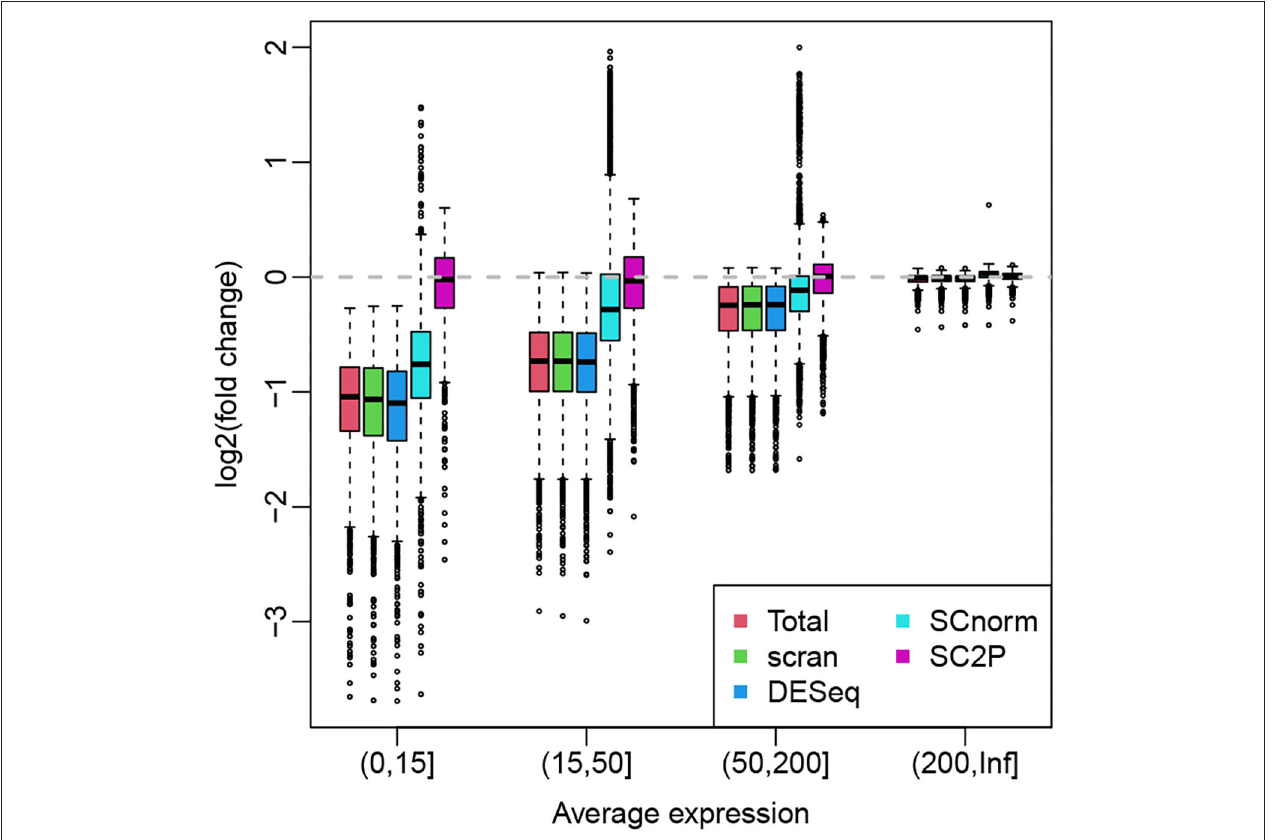
FIGURE 6 | Box plots of log fold changes of normalized gene expression from different methods. The genes are stratified by average expressions. The log fold changes are computed based a two-group comparison, where the two groups contains cells with high and low sequencing depths. All cells are H1 hES cells.